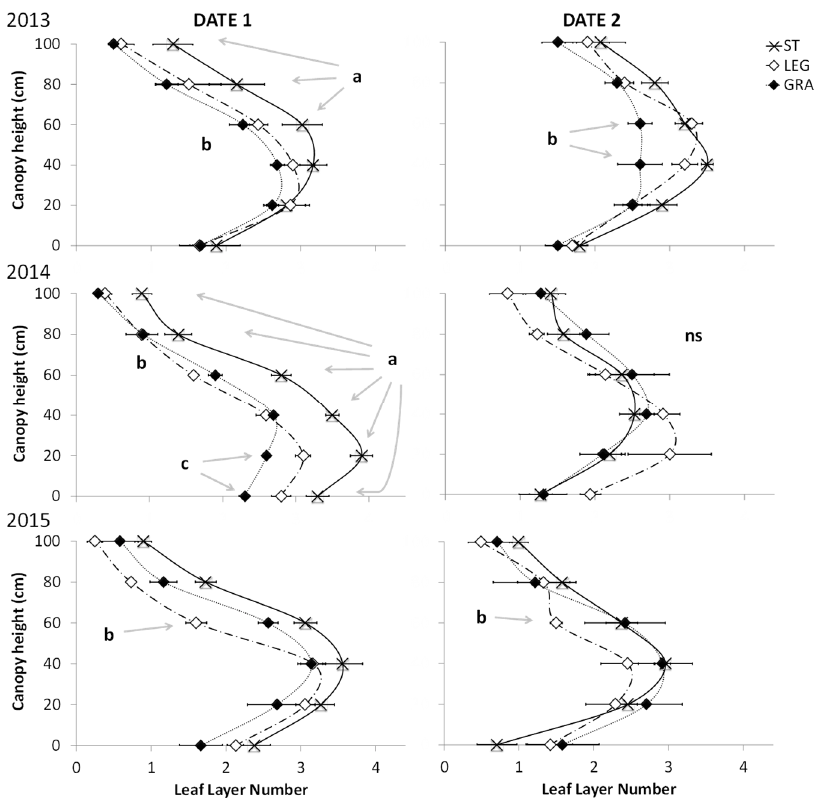
Figure 6. Leaf layer number, from the base to the top of the canopy wall at dates 1 and 2 of the canopy density measurements. Values are the mean ± standard error and different letters indicate significant differences among treatments at p < 0.05, ns—not significant. Table 3. F-statistics and p -value of the two-way ANOVA on average porosity, LLN, and PIL during dates 1 and 2 of field monitoring. Significance of the season and soil management treatment effects and of the interaction between main factors. Main factor